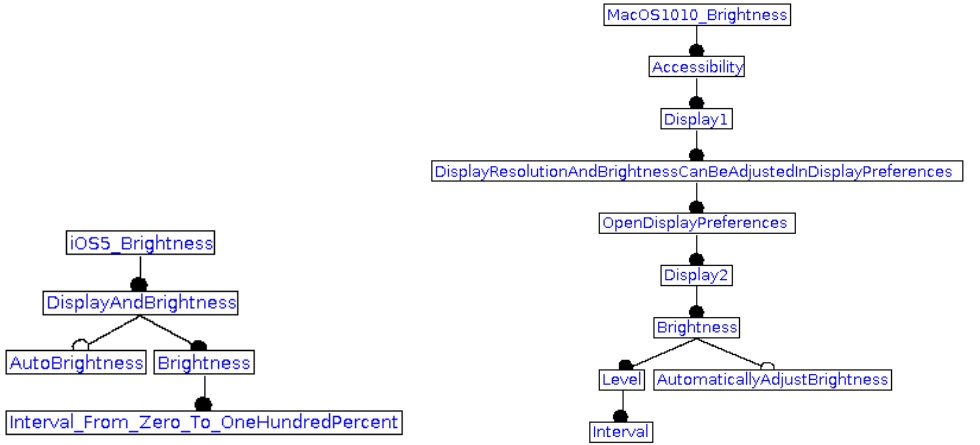
Figure 2. Feature models for Brigthness of iOS (left-hand side, version iOS 5) and MacOS (right- hand side, version MacOS 10.10) represented with FAMILIAR [26]. Black circles indicate mandatory features; white circles indicate optional